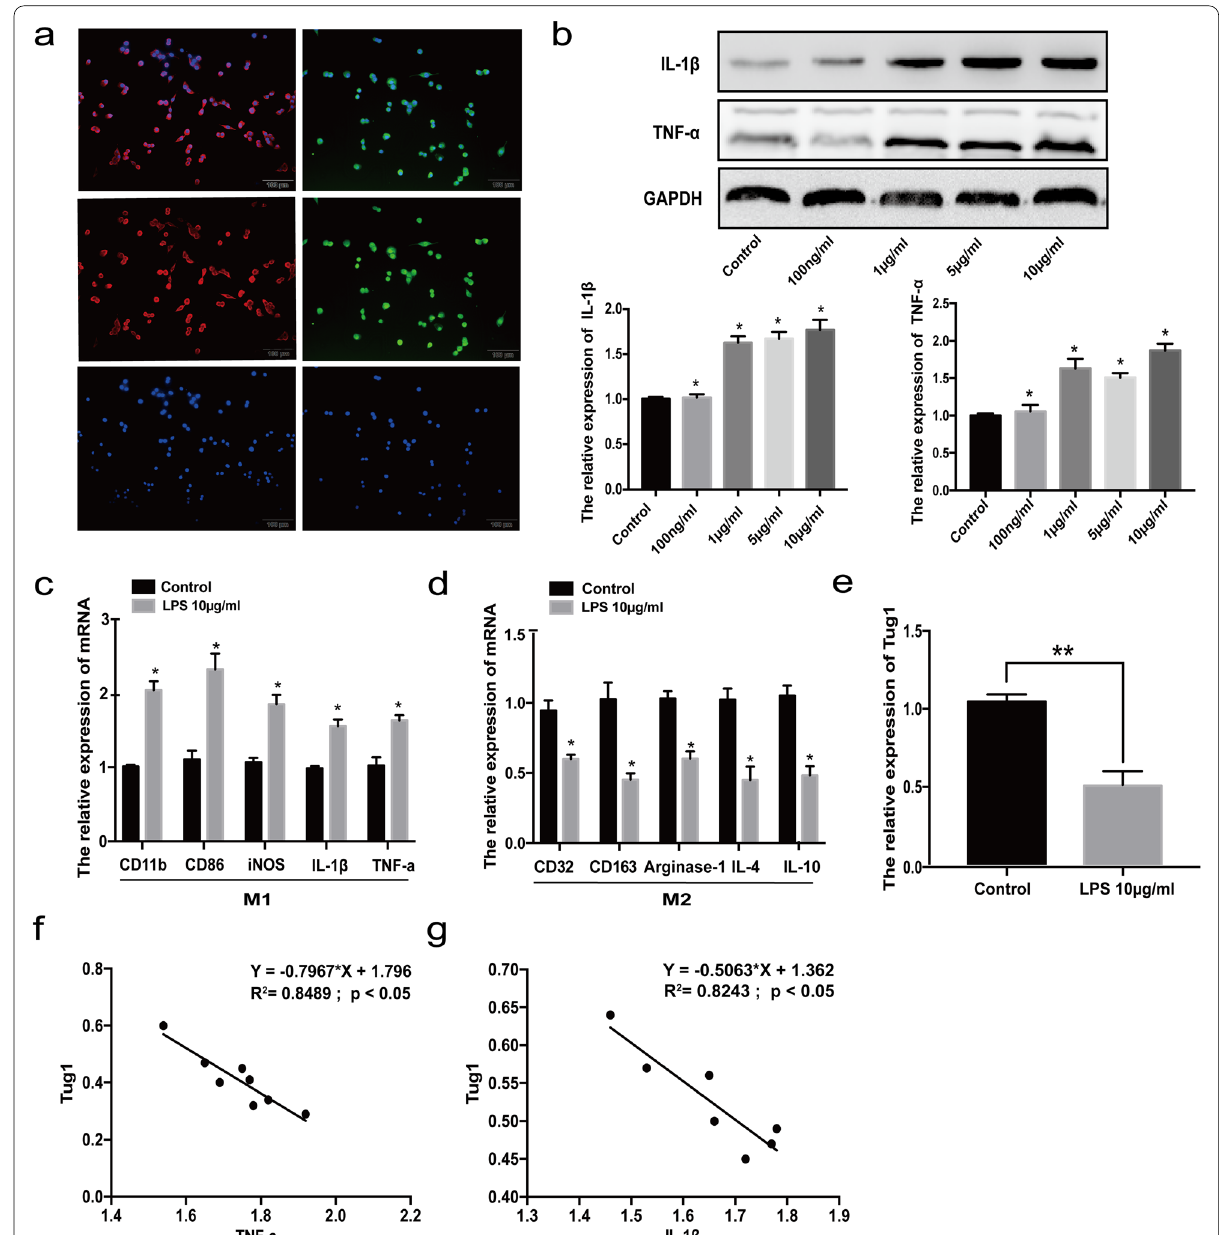
Fig. 3 Tug1 was downregulated in the LPS-treated microglia. a Phenotyping of microglial cells. The immunofluorescence showed positive expression of Iba1 and F4/80. b Western blotting analysis of IL-1β and TNF-α in rats at different LPS concentrations. c The mRNA expression of M1 type-associated markers CD11b, CD86, iNOS, IL-1β and TNF-α in microglial cells. d The mRNA expression of M2 type-associated markers CD32, CD163, Arginase-1, IL-4 and IL-10 in microglial cells. e The relative level of Tug1 in the LPS-treated microglia. f‑g Pearson correlation analysis between Tug1 and TNF-α or IL-1β in the LPS-treated microglia. (* P < 0.05, ** P < 0.01 vs